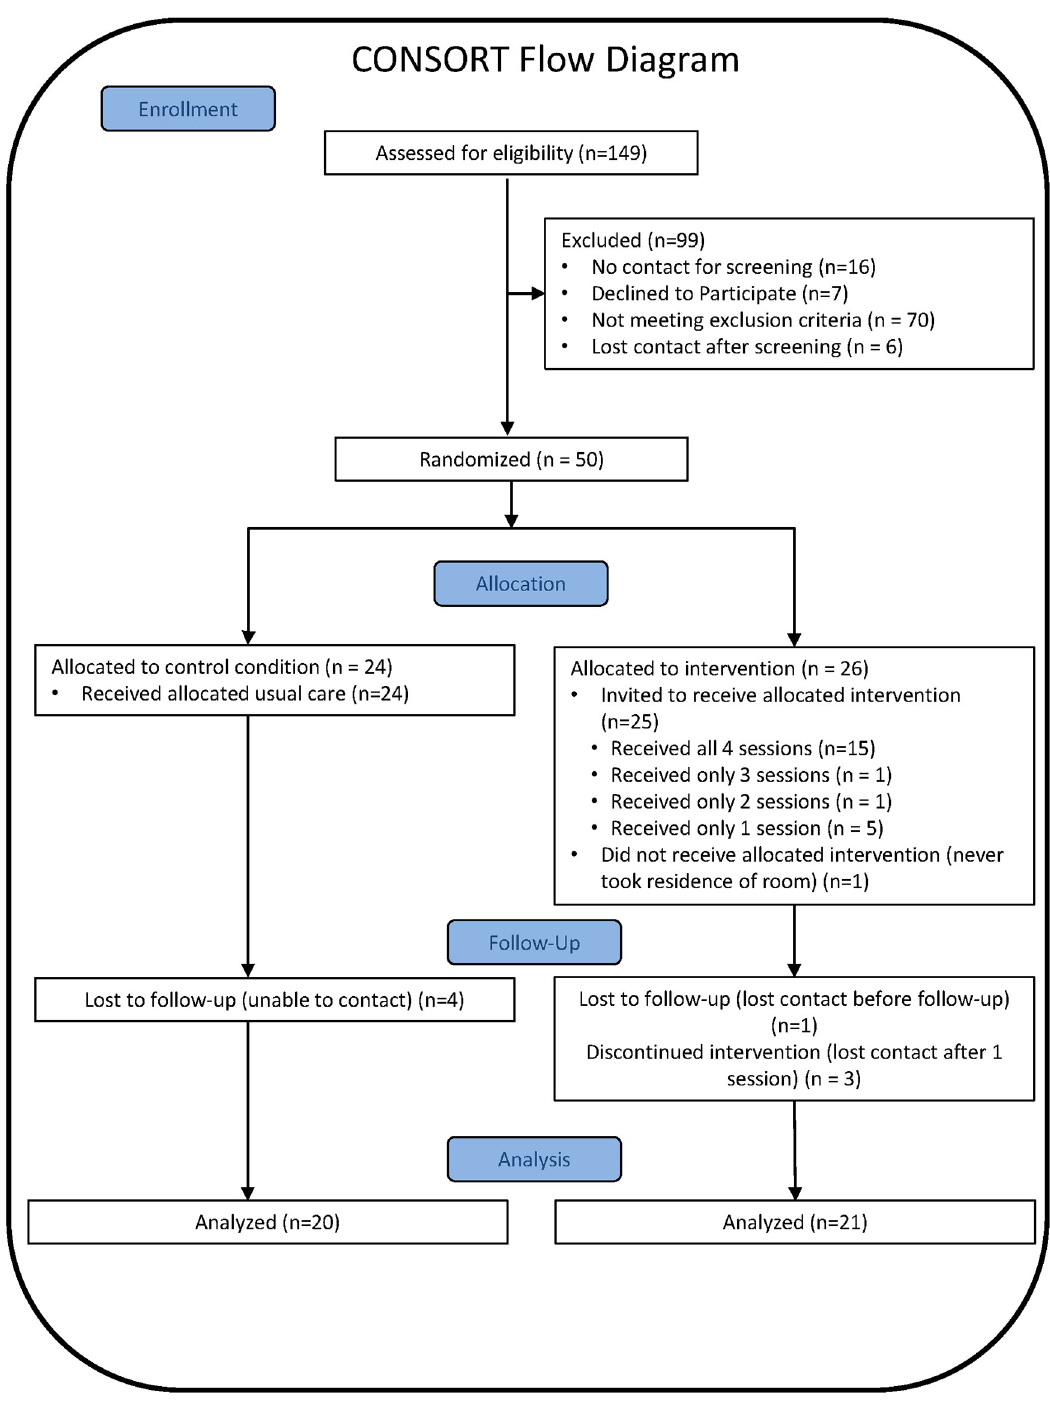
Fig 1. CONSORT diagram of pilot study